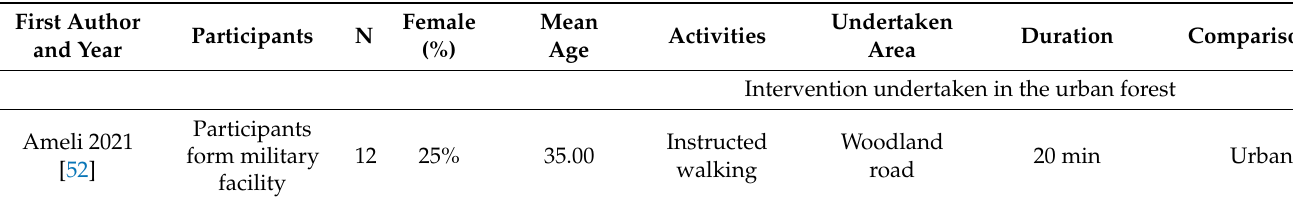
Table 3. Main characteristics of included